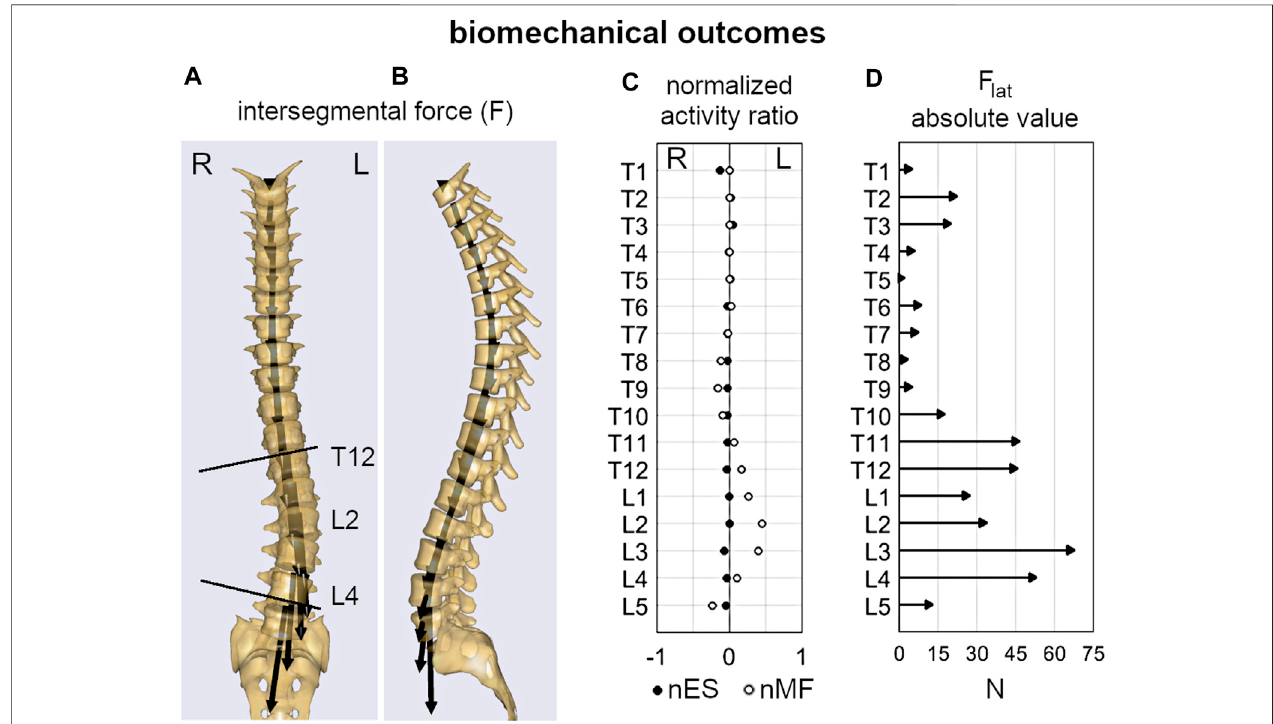
FIGURE4| Exampleofthebiomechanicaloutcomescomputedbyinversestaticanalysisforthesubjectdepictedin Figure2 .Intersegmentalforcevector,F (A,B) ; normalized activity ratio of multi fi dus and erector spinae (nMF and nES) muscle (C) ; absolute value of the lateral shear, F lat (D) .